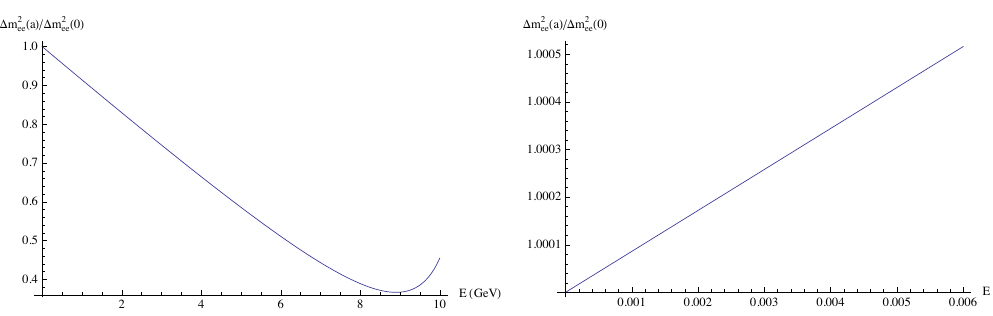
Figure 1 . In the left panel, plotted is the ratio (cid:1) m 2 GeV. The right panel is to magnify the low energy region of (cid:1) m 2 showing that the matter e(cid:11)ect in (cid:1) m 2 region. The mixing parameters and the matter density that we used are: (cid:1) m 2 (cid:1) m 2 = 7 : 5 (cid:2) 10 (cid:0) 5 eV 2 , sin 2 (cid:18) 13 = 0 : 022, sin 2 (cid:18) 12 = 0 : 30, and (cid:26) = 2 : 8 g/cm 3 21